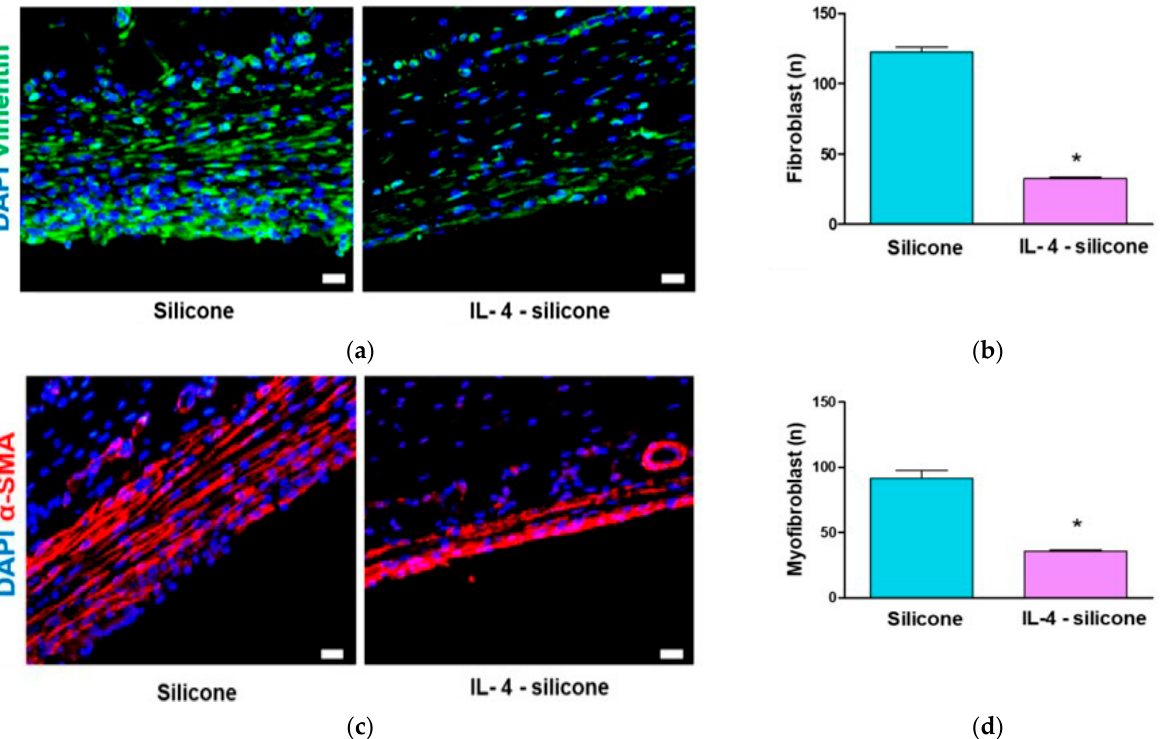
Figure 6. Evaluation of the numbers of fibroblasts and myofibroblasts around the implants. ( a ) Representative CLSM images of tissues. Green fluorescence indicates vimentin-positive fibroblasts. ( b ) Quantification of vimentin-positive fibroblasts. ( c ) Representative CLSM images of tissues. Red fluorescence indicates α -SMA-positive myofibroblasts. ( d ) Quantification of α -SMA-positive myofibroblasts. Scale bars represent 50 μ m. The data represent means ± SEMs, five animals per group. * Significantly ( p < 0.05; t -test) different from the bare silicone implant group.